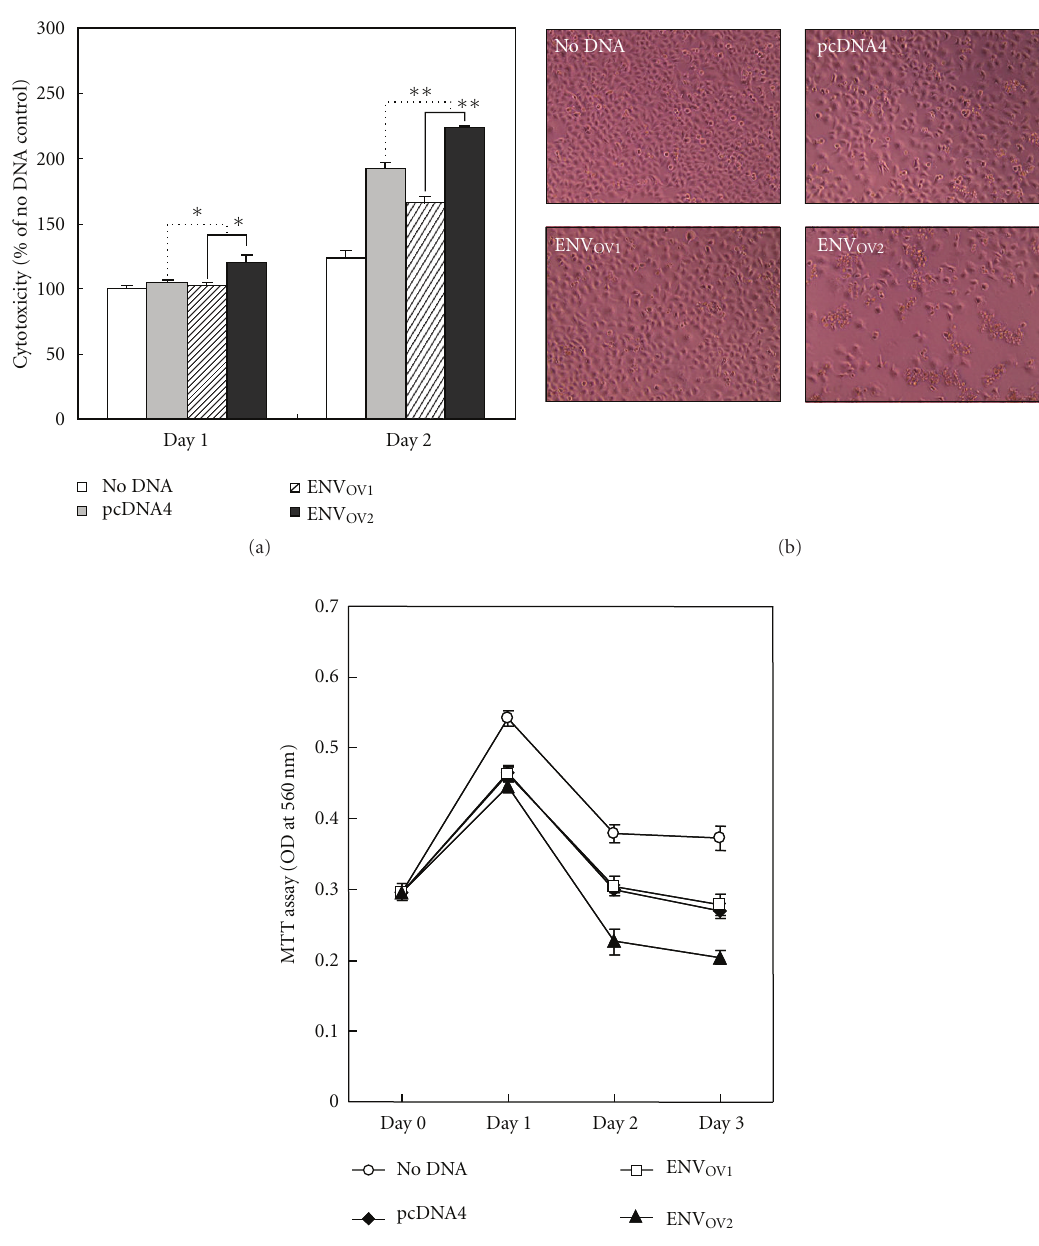
Figure 4: Cytopathic e ff ects of the ENV OV1 and ENV OV2 polypeptides. (a) and (b) Cytotoxic property of the ENV OV2 polypeptide, but not ENV OV1 polypeptide, wasobserved during cytotoxicity assayby measurement of lactate dehydrogenase release and morphologicexamination of cells (200x magnification). The degree of cytotoxicity was normalized to the no DNA (Panel (a)). (c) ENV OV2 polypeptide’s inhibitory e ff ect on cell proliferation was demonstrated by MTT assay, which measures cell viability, following overexpression. All experiments were performed in triplicate. ∗ and ∗∗ indicate statistical significance ( ∗ P < . 05; ∗∗ P < .